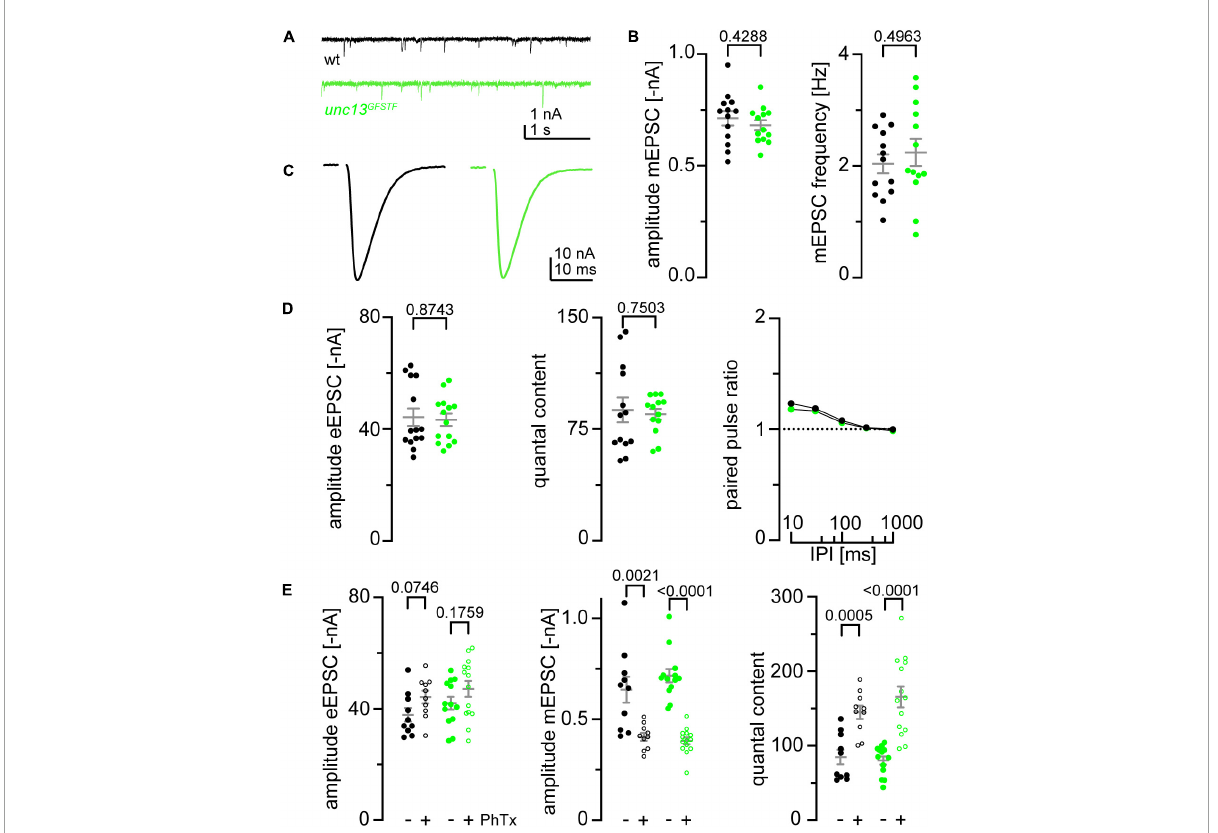
FIGURE3 Endogenous tagging of unc-13 leaves synaptic function and presynaptic homeostatic potentiation undisturbed. (A) Representative traces of miniature excitatory postsynaptic currents (EPSCs) recorded in 1 mM Ca 2 + at wildtype (wt, black) and unc-13 GFSTF (green) neuromuscular junctions (NMJs). (B) miniature excitatory postsynaptic currents (mEPSC) amplitude and frequency are unaltered in unc-13 GFSTF larvae (green, n = 13 NMJs from seven larvae) compared to wt (black, n = 13 NMJs from eight larvae). (C) Representative traces of evoked EPSCs recorded in 1 mM extracellular Ca 2 + in both genotypes. (D) Evoked excitatory postsynaptic currents (eEPSC) amplitude, quantal content, and paired-pulse-ratios measured with different interpulse intervals (IPI; 10, 30, 100, 300, and 1000 ms) remain unaltered in unc-13 GFSTF animals (wt: n = 14 NMJs from eight larvae; unc-13 GFSTF : n = 14 NMJs from seven larvae). (E) eEPSC amplitude, mEPSC amplitude and quantal content in wt (black) and unc-13 GFSTF (green) animals treated with Philanthotoxin (PhTx) in dissolved in dimethyl sulfoxide (dmso) (+, open circles) or dmso (–, filled circles). unc-13 GFSTF larvae still exhibit presynaptic homeostatic potentiation in response to PhTx stimulation (wt: 10 NMJs from seven larvae in dmso, 10 NMJs from five larvae in PhTx; unc-13 GFSTF : 13 NMJs from six larvae in dmso, 14 NMJs from seven larvae in PhTx). Whisker